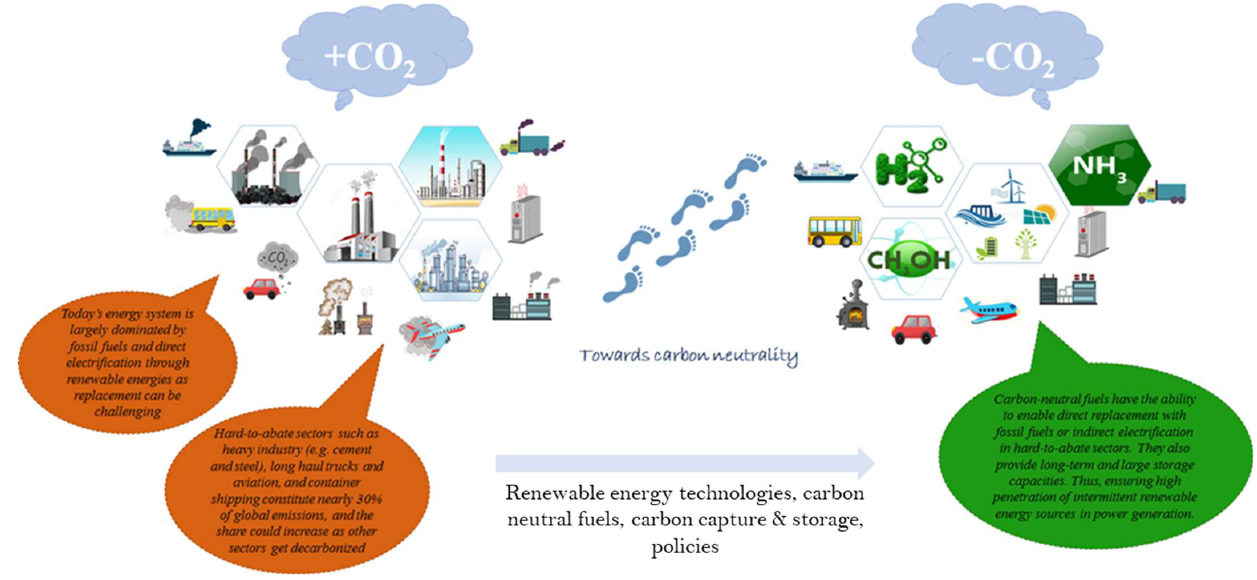
Figure 1. Carbon neutral fuels in future net zero carbon emissions.